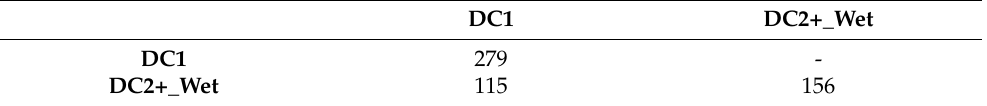
Table 11. Variance components estimates used to calculate Index two.